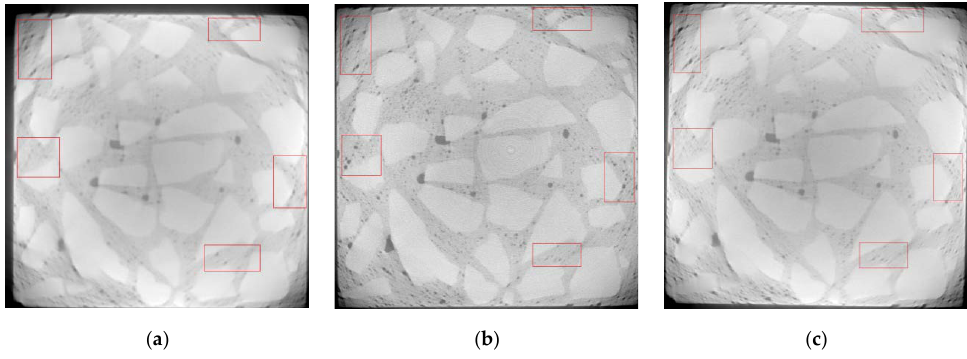
Figure 4. CT images of D5 under different dry and wet cycles of sulfate attack: ( a ) 0 dry–wet cycle; ( b ) 40 dry–wet cycles; ( c ) 80 dry–wet cycles.